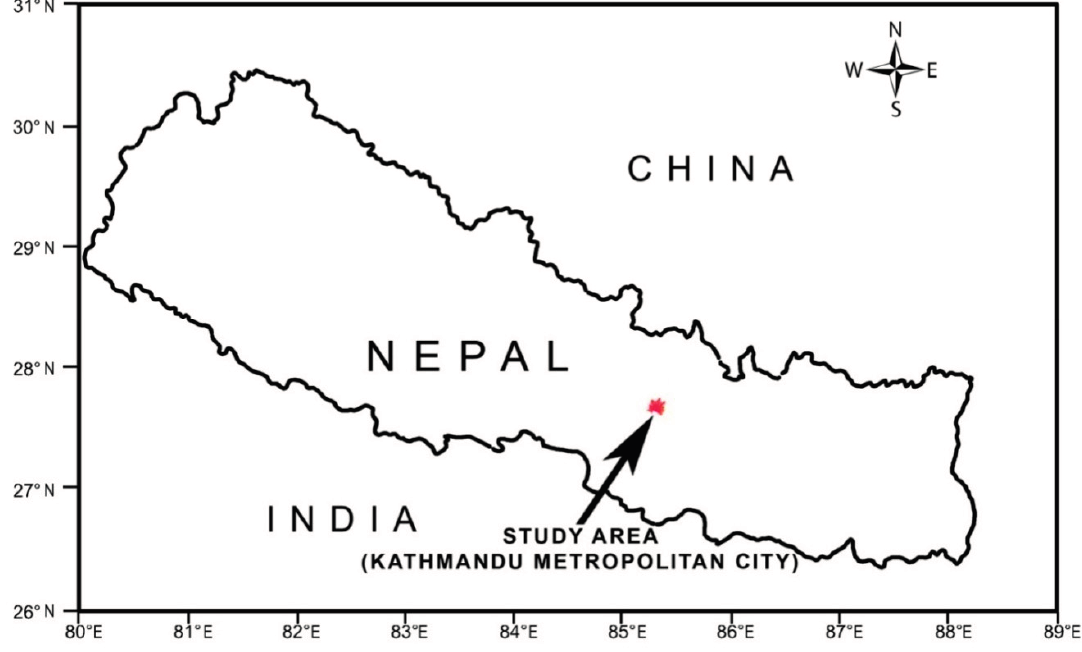
Figure 1. Location of study